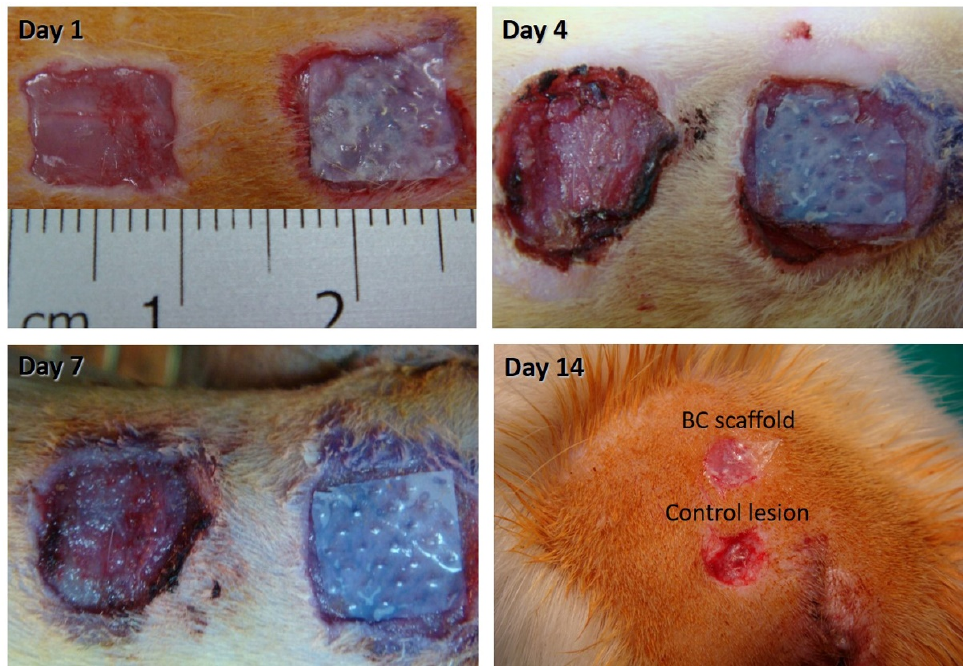
Figure 4. Rat model of skin defects healing over time without ( left side ) or with bacterial cellulose scaffold covering ( right side ).